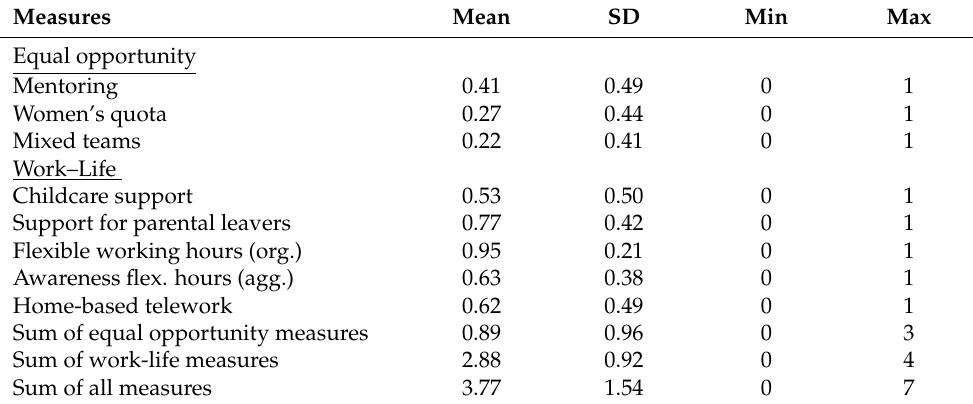
Table 2. Availability of work–life and equal opportunity measures at establishments (N establishments = 122; N employees = 6439).